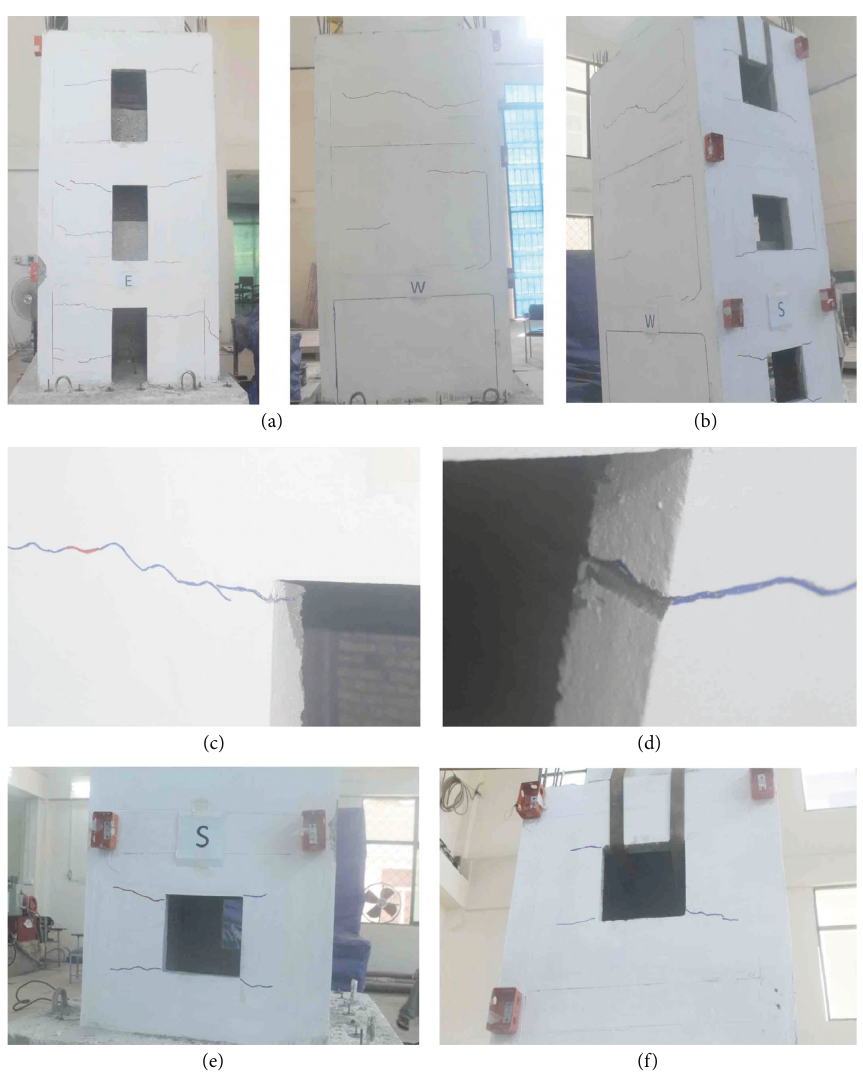
Figure 6: Damages observed in the hybrid masonry-infilled frame structure under 200% earthquake motions. (a) In-plane loaded frame. (b) Face-loaded frame. (c) Through horizontal cracks in masonry panel. (d) Horizontal sliding at the masonry bed joint. (e) Damage to out-of- plane panel on ground story. (f) Damage to out-of-plane panel on third